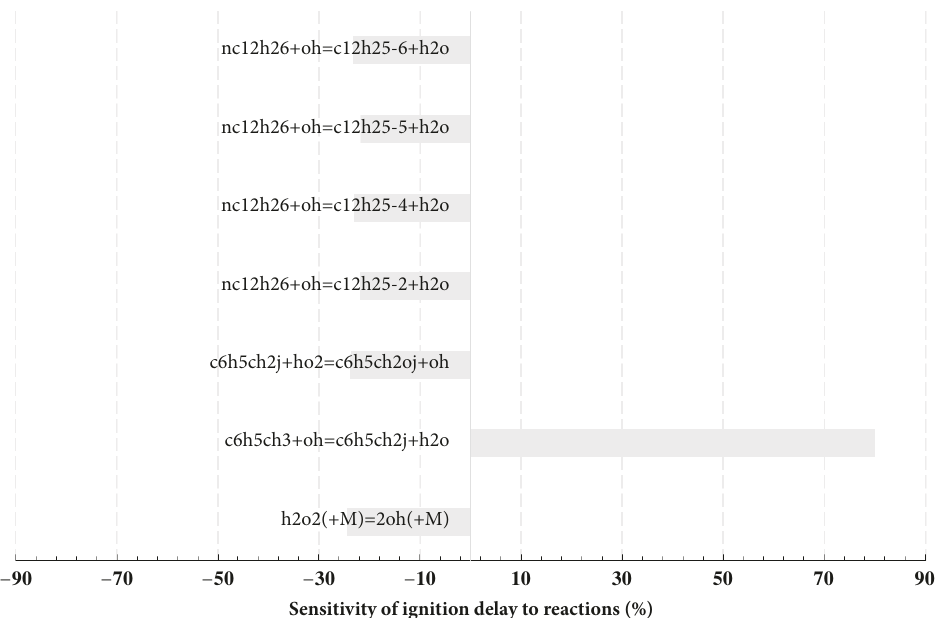
Figure 20: Sensitivity analysis for total ignition delays for prediction of ignition under constant-volume conditions at initial conditions of 900 K, 40 bar, and fuel-air equivalence ratio of 1.0.